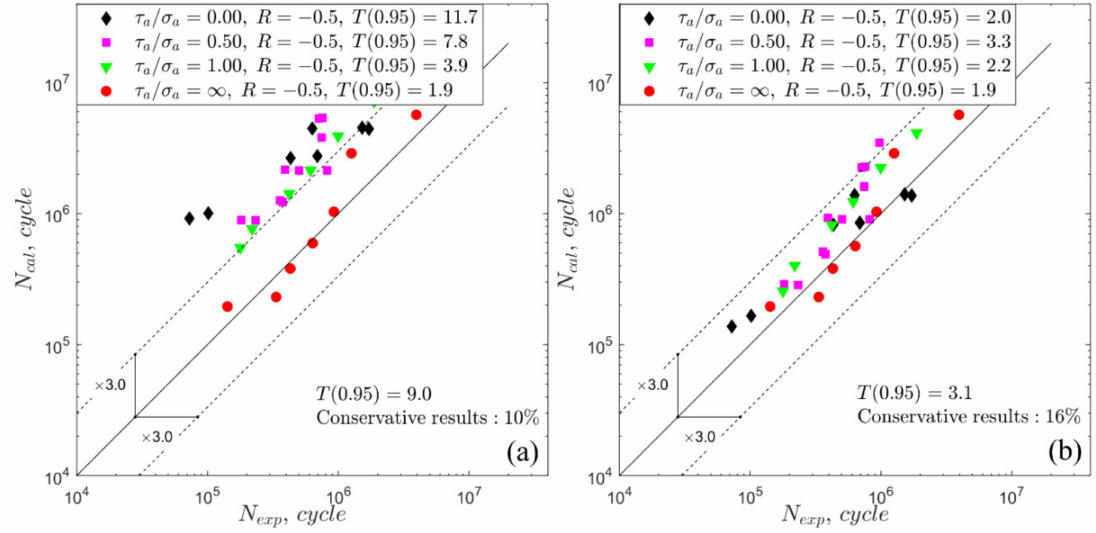
Figure 9. Experimental and calculated fatigue lives for the Crossland model under R = − 0.5 for 7075-T651 aluminium alloy: ( a ) fixed material parameters; ( b ) life-dependent material